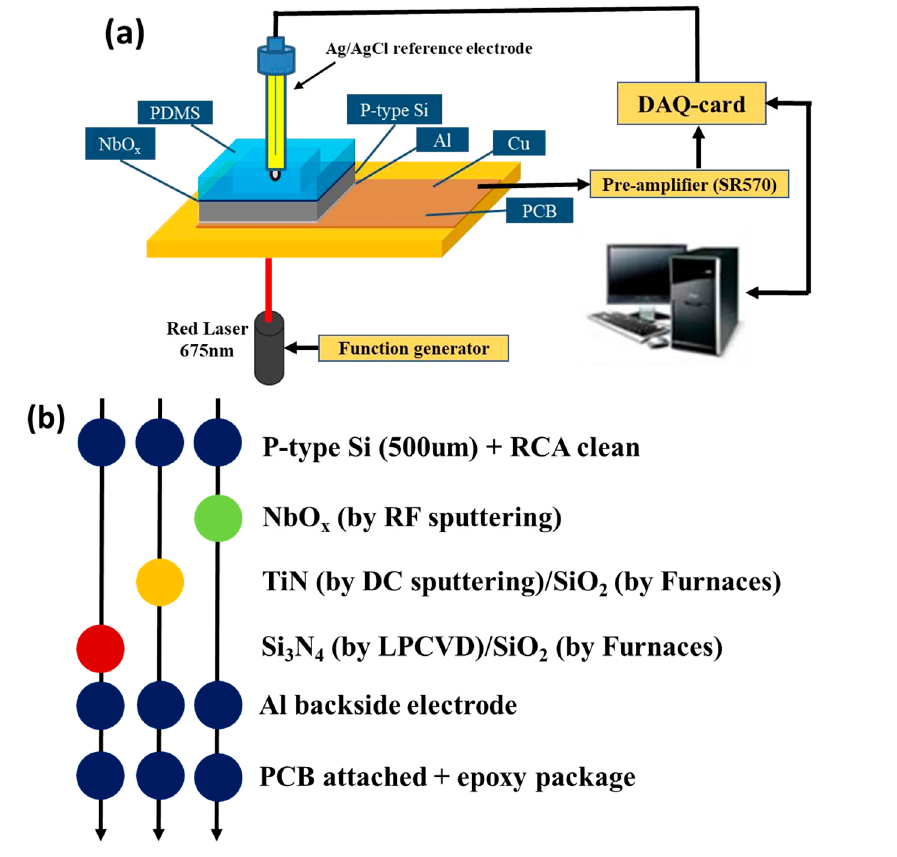
Figure 1. ( a ) Schematic plot of 3 device structures and ( b ) its process